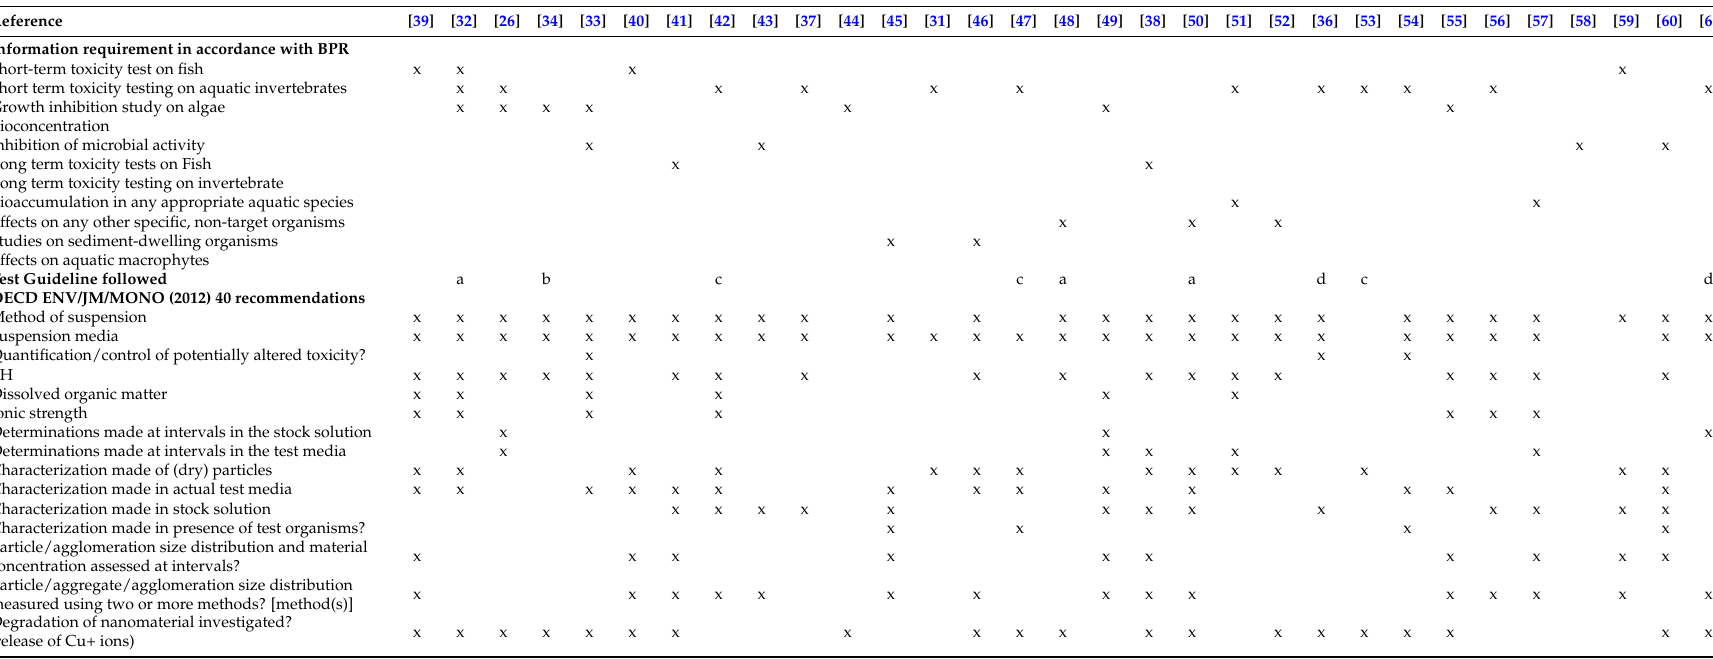
Table 3. Overview of studies published in the open literature on CuO Nanoparticles (NPs) and their relation to the information requirement of the Biocidal Product Regulation (BPR). Furthermore, it is shown which test guidelines the studies have used and which of the nanospecific Organisation for Economic Co-operation and Development (OECD) test and characterization recommendations [18] have been